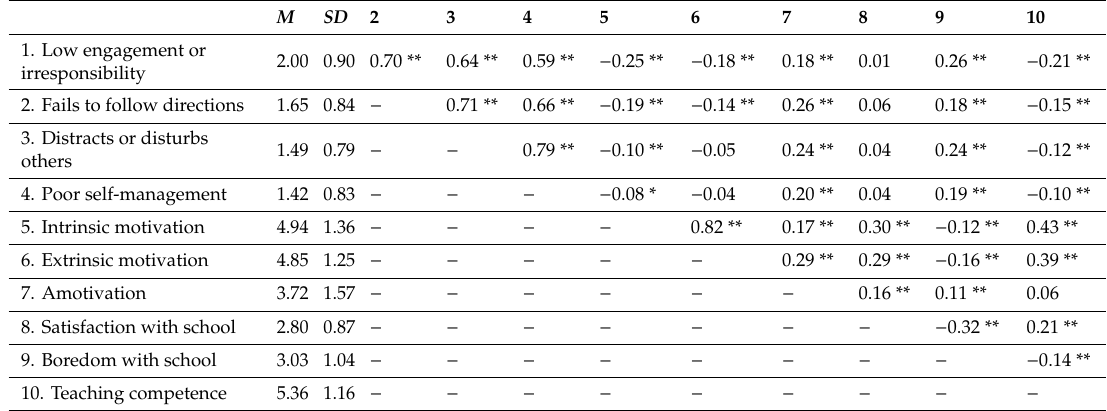
Table 1. Descriptive analysis and correlation between